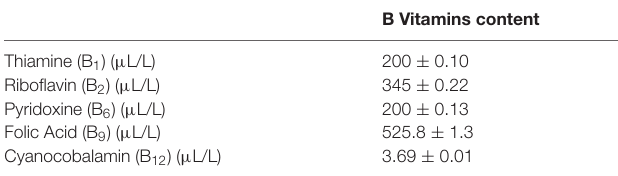
TABLE 3 | Water-soluble B vitamins content of fresh milk from Zamorano-Leonese donkey.